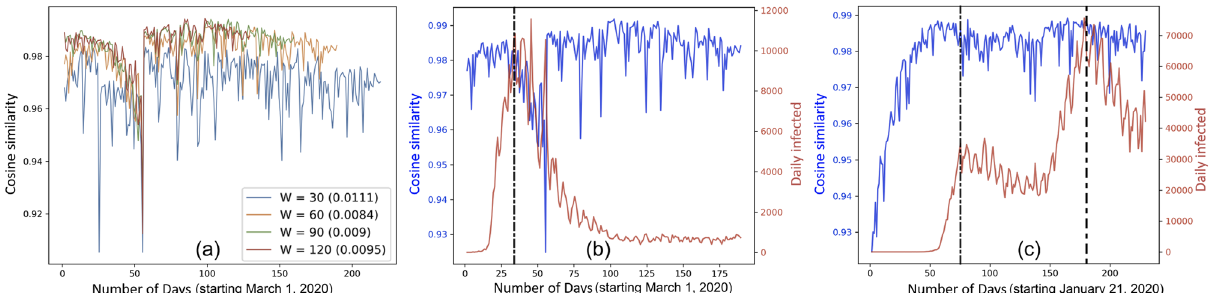
Figure 2. Phases in the pandemic timeline. ( a ) Cosine similarities of consecutive temporal influence networks generated from the NY county COVID-19 infection data for varying time windows ( W ); Cosine similarities between consecutive temporal networks and total daily infected numbers for W = 60 for ( b ) NY state counties (starting 1st March, 2020) and ( c ) US states (starting 21st January, 2020), with the black dotted lines indicating phase